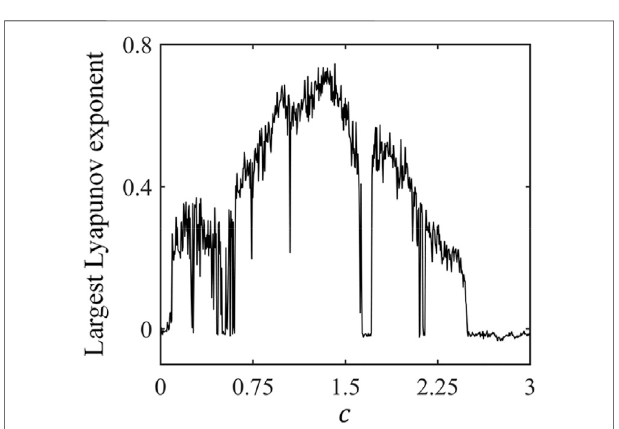
FIGURE 4 | Lyapunov exponent